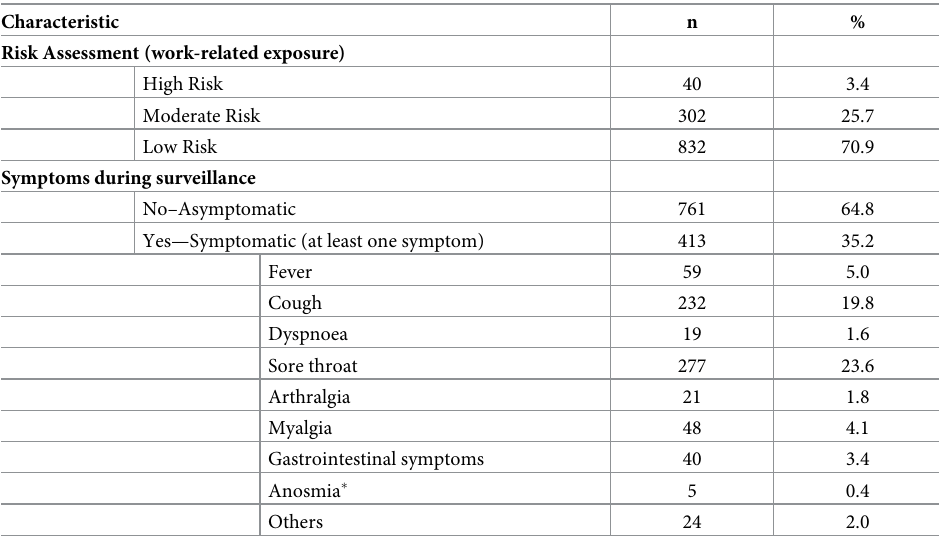
Cumulative total for all symptoms may exceed total n = 1,174 as there might be HCWs with multiple